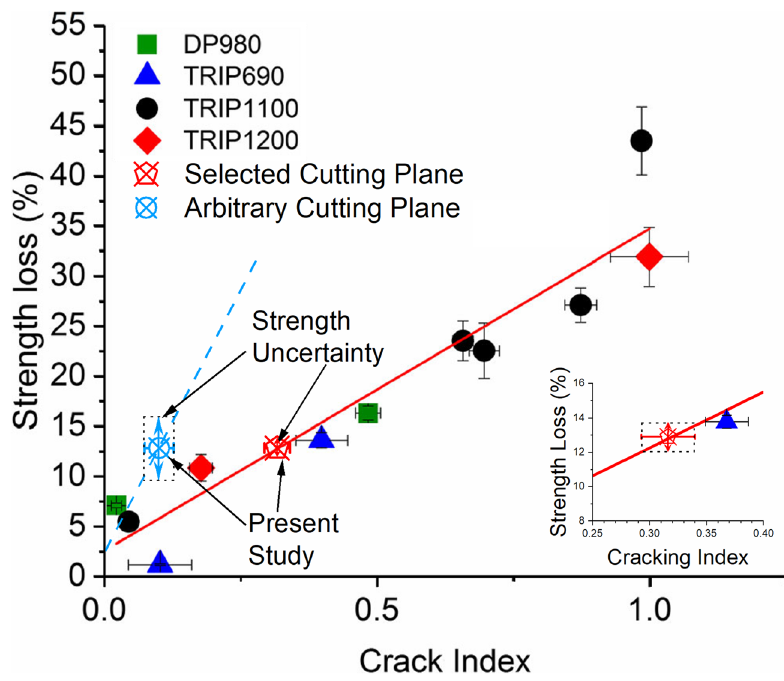
Fig. 5 Correlation between cracking index and percent- age tensile shear strength loss for various steels with data included from the present study, with an inset showing a higher resolution view of points from cracking index val- ues from 0.25 to 0.40. Adapted from